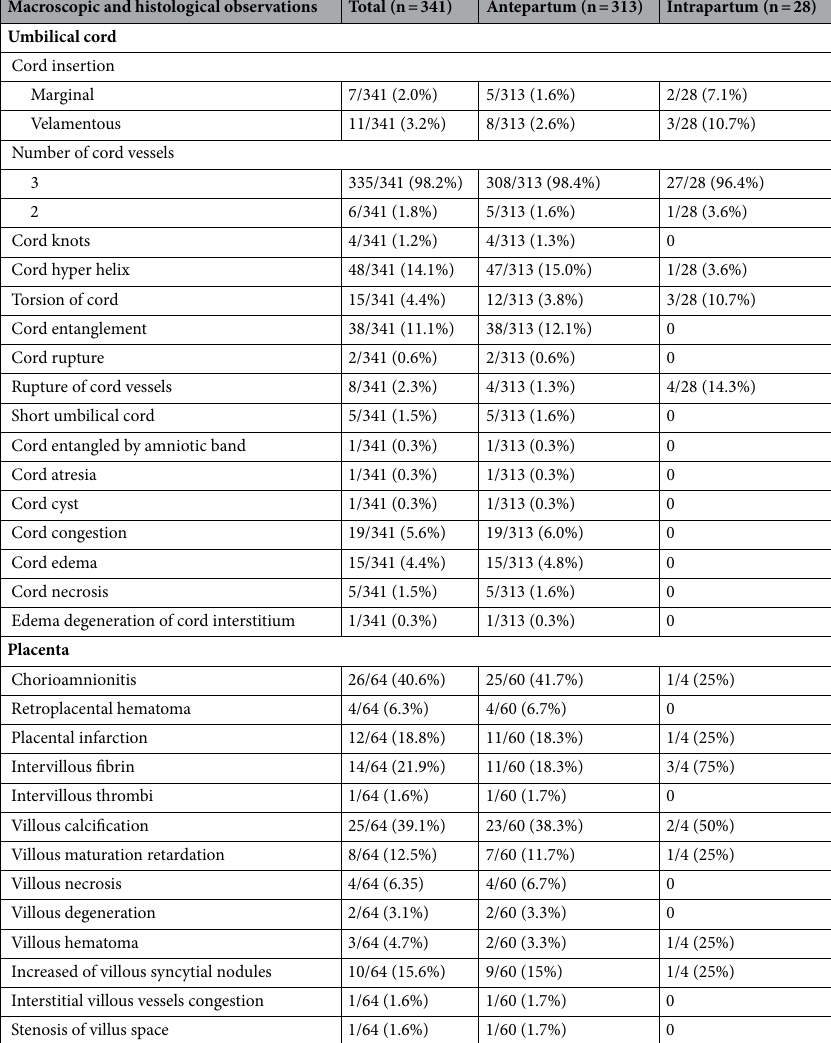
Table 4. Macroscopic and histological placental observations in stillbirths. Data are n/N